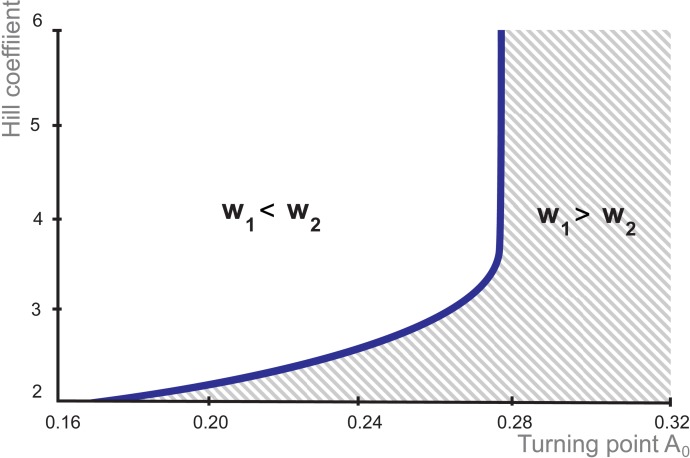
Dependence of the Hill coefficient value on the value of OS activating signal at which transition from differentiation to pluripotency occurs.The horizontal and vertical axes represent the values of parameters A0 and h, respectively. The curve distinguishes between pluripotency and differentiation states.